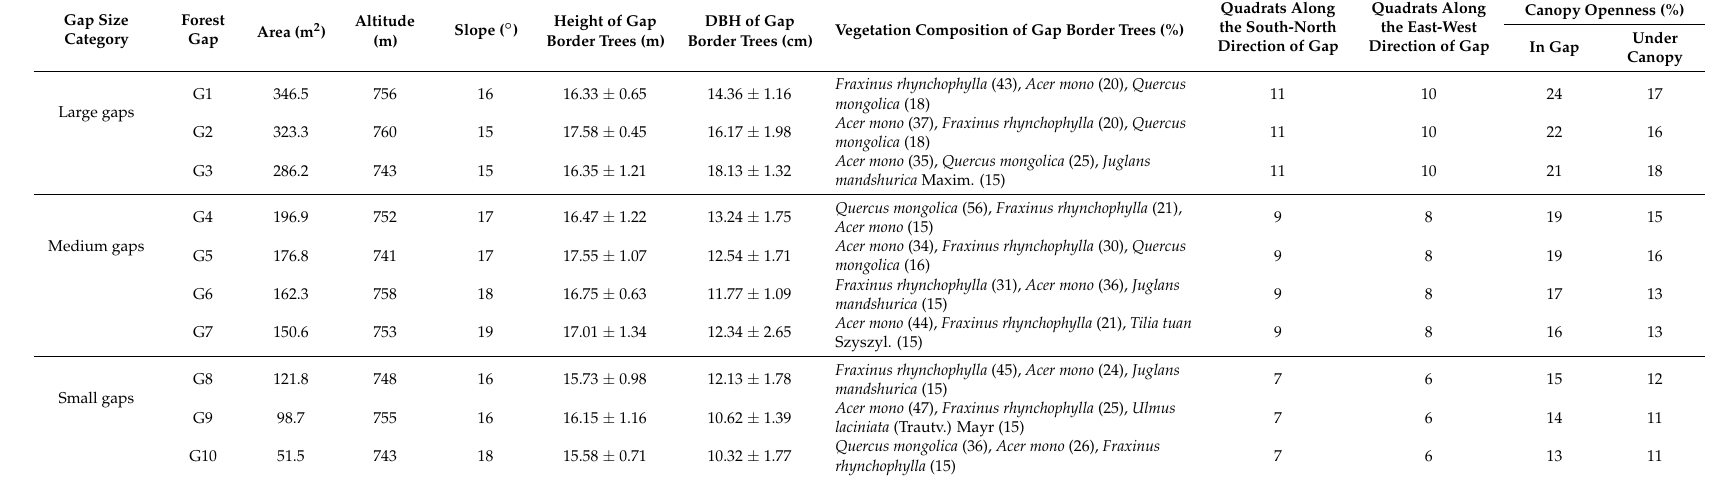
Table 1. Description of the forest gaps investigated in the study of temperate secondary